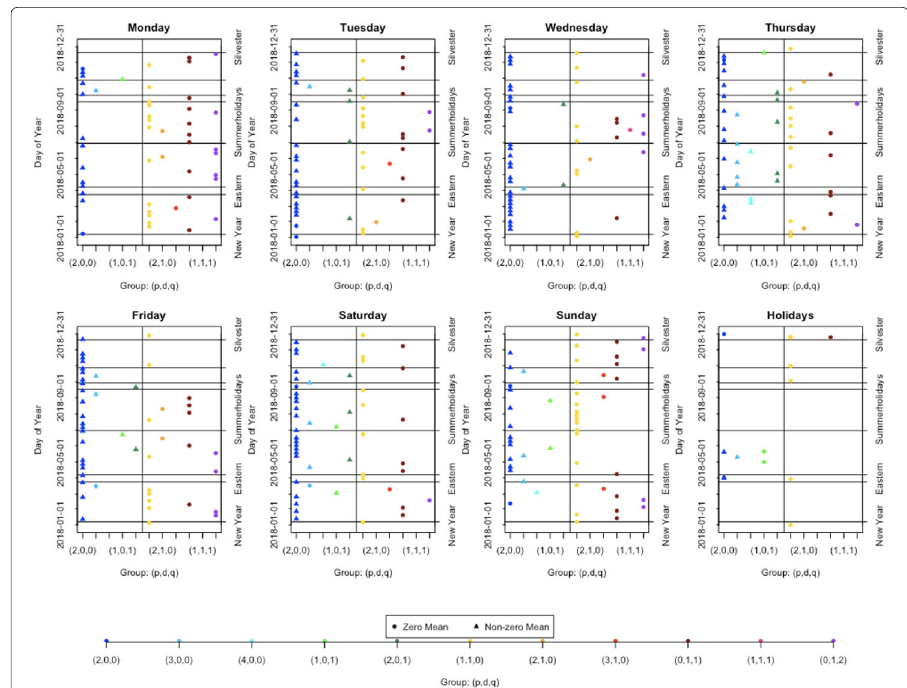
Fig. 5 Cluster of the Day-Ahead prices with AIC as similarity